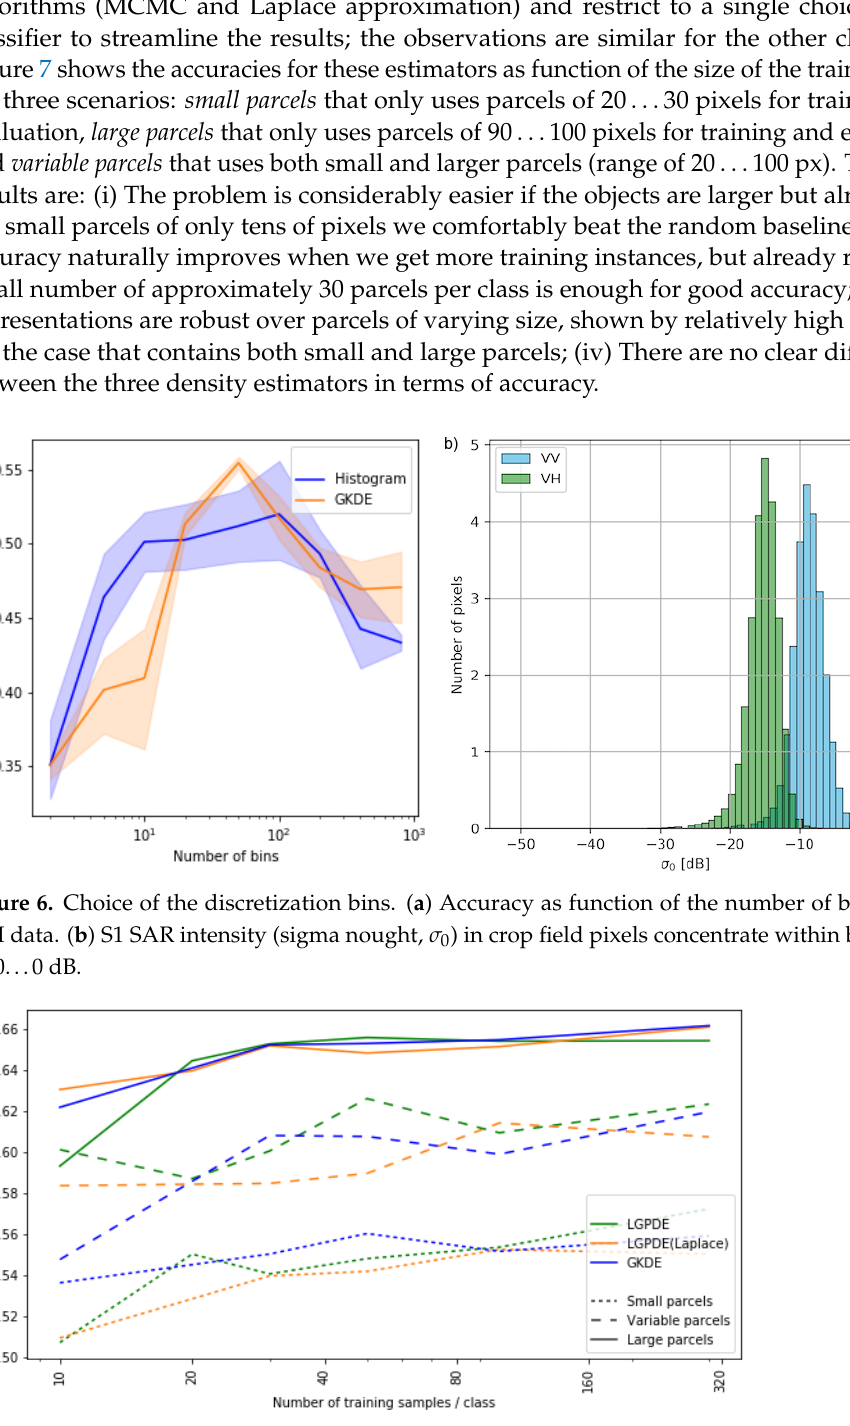
Figure 7. Effect of field parcel size (line style) on MLP accuracy for different estimators (line color). Confidence intervals omitted for visual